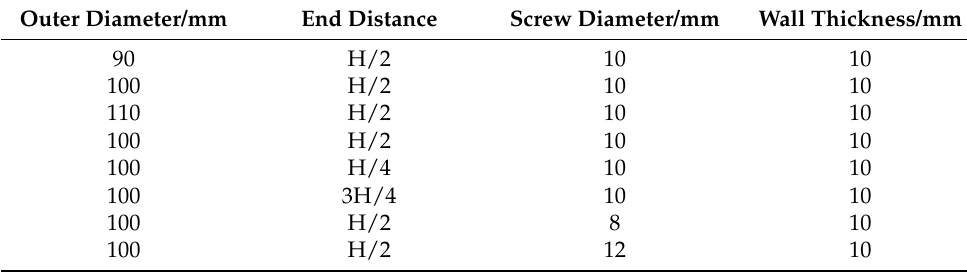
Figure 1. Sketch diagram of D100-1/2H-M10-1. Table 1. Geometric data of different composite joint